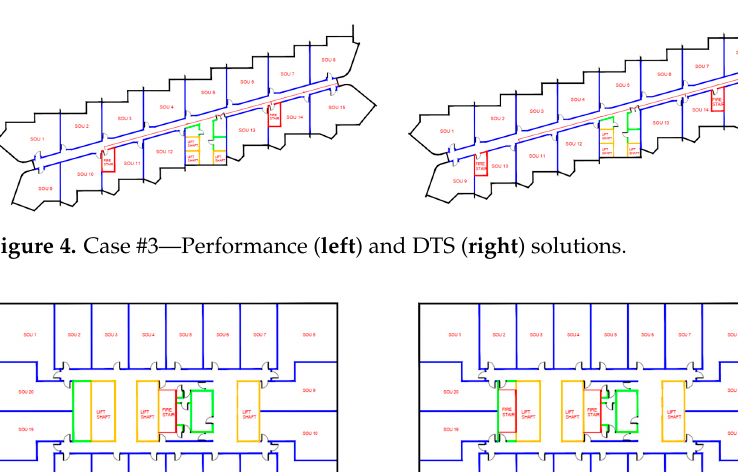
Figure 5. Case #4—Performance ( left ) and DTS ( right ) solutions. Table 2. Characteristics of the building case studies.